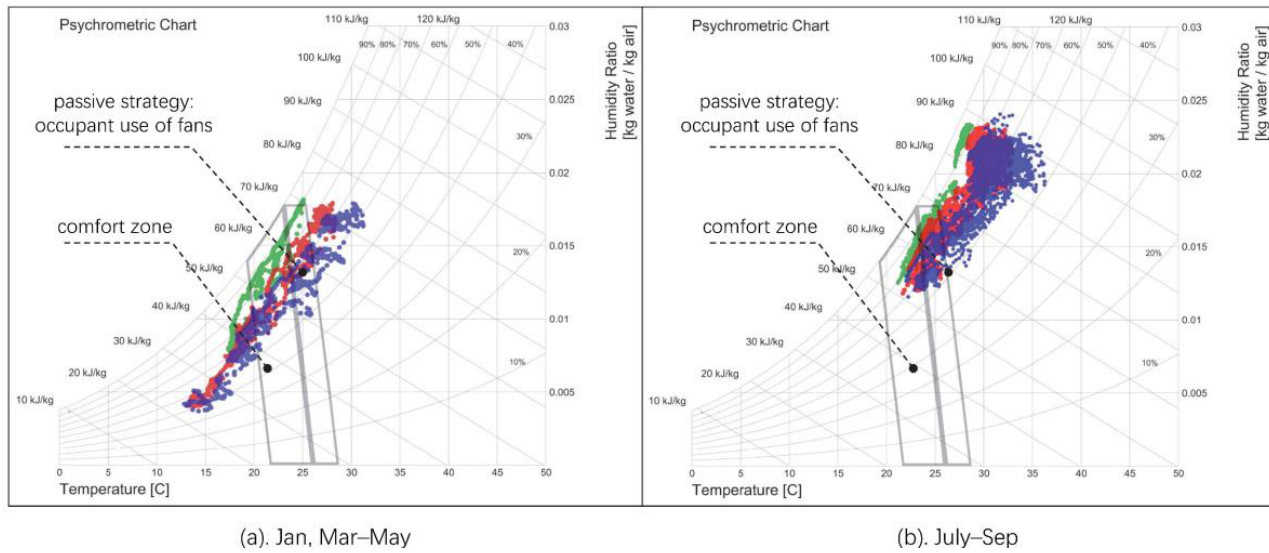
Figure 17. Psychrometric chart analysis (March – September 2021), drawn by the students.